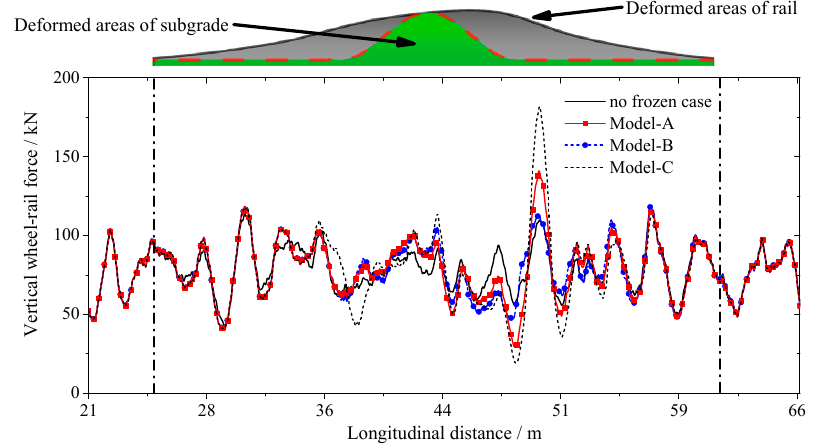
Figure 10. History of vertical wheel-rail force with different models.